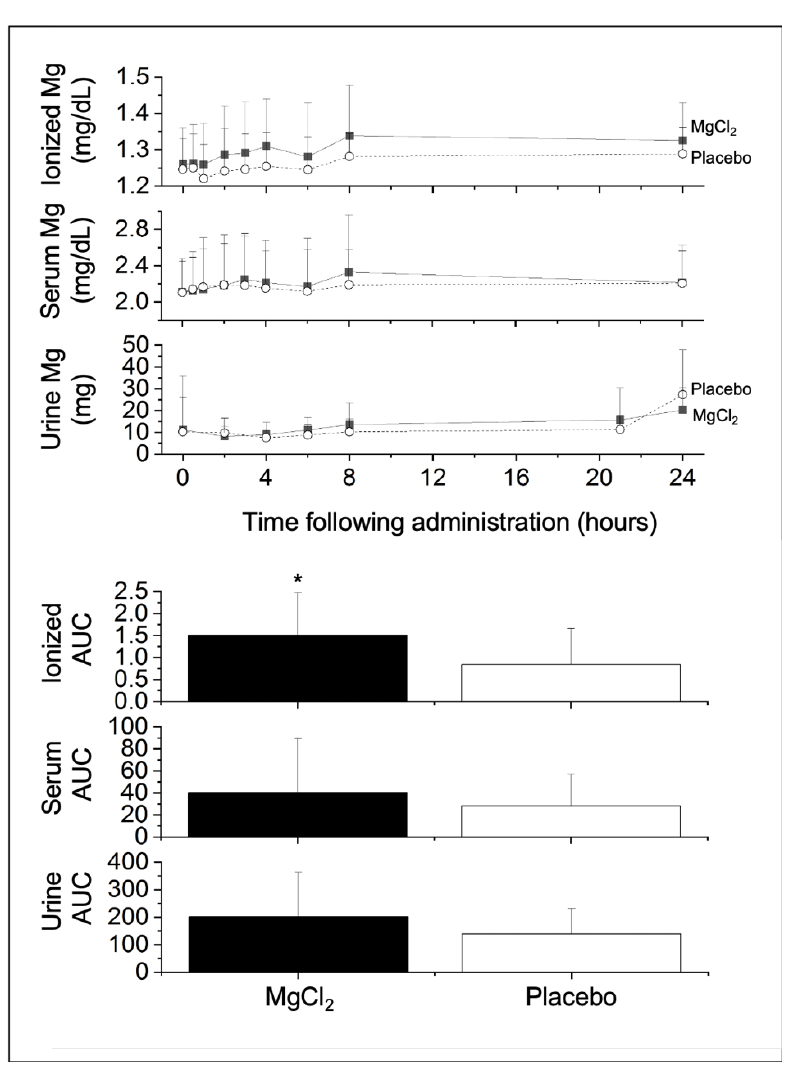
Figure 1. Average whole blood concentration of ionized magnesium (iMg 2+ ) and serum total magnesium concentrations, as well as urinary magnesium content (top); total area under the curve (AUC) in mg/dL .24hour for iMg 2+ and serum total Mg or mg 24hour for urine Mg (bottom) over 24 h post-treatment for MgCl 2 treatment vs. placebo. * Differences between MgCl 2 versus placebo, p < 0.05. To convert between mg/dL and mmol/L, divide by 2.43.